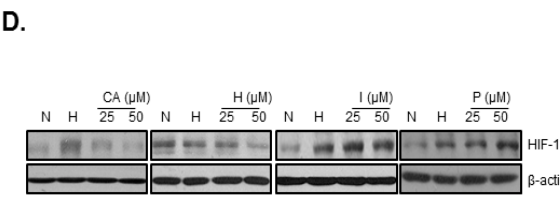
Figure 1. Inhibitory effect of CPE containing CA on HIF-1 α expression in hypoxic DU145 cells. ( A ) DU145 cells were treated with CPE (0 and 100 µg/mL) for 4 h. Levels of SPHK-1, HIF-1 α , and β -actin expression were determined by western blot analysis; ( B ) Fold change of western blot. Data are presented as means ± S.D. (**) p < 0.01 compared to control under hypoxia. (###) p < 0.001, (##) p < 0.01, compared to control under normoxia; ( C ) DU145 cells were treated with CPE (0, and 100), SPHK-1 activity was measured by using SPHK-1 activity assay kit. Data are presented as means ± S.D. (##) p < 0.01 compared to control under normoxia. (**) p < 0.01 compared to control under hypoxia; ( D ) Effect of four major compounds of Crataegus pinnate fida on hypoxia-induced HIF-1 α expression in DU145 cells. (N: Normoxia, H: Hypoxia, CA: Chlorogenic acid, H: Hyperoside, I: Isoquercetin, P: Procyanidin B2).